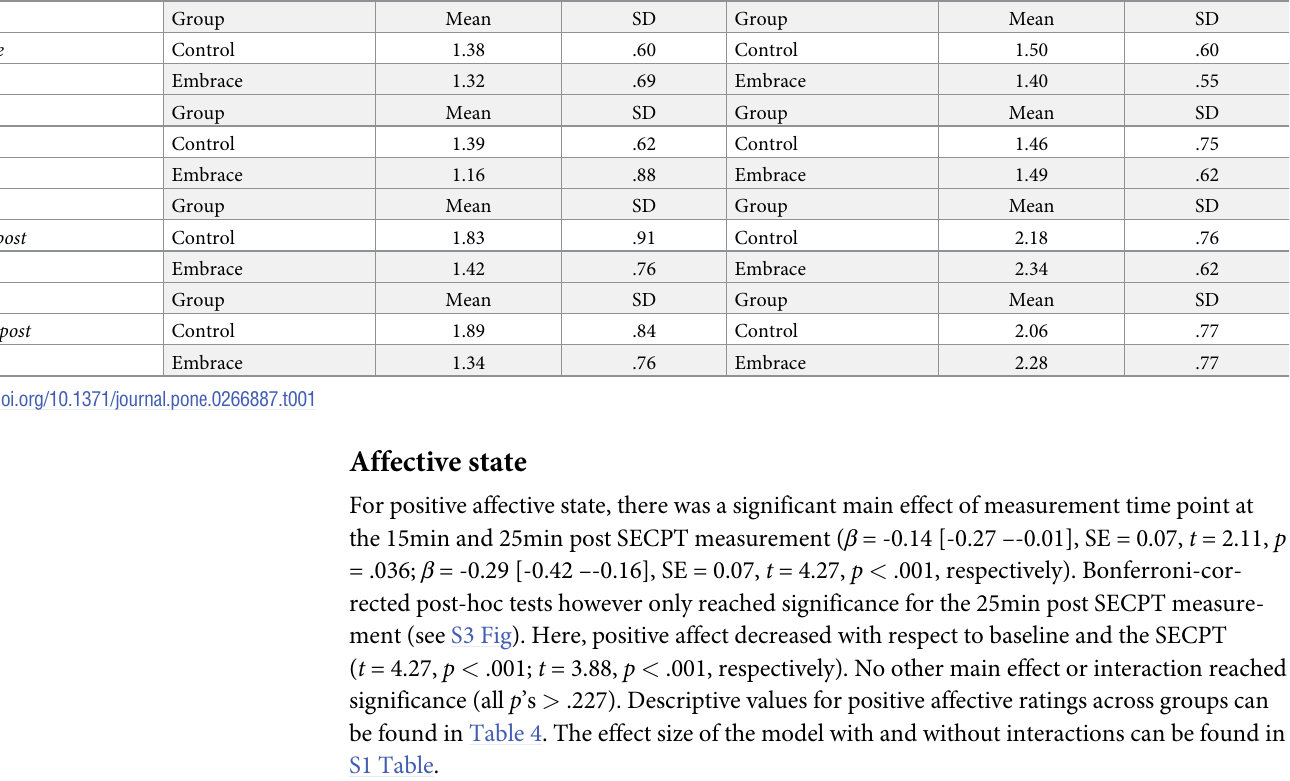
Table 1. Descriptive values (mean value and standard deviation) of logarithmized cortisol values across the four measurement time points broken down by condi- tion and sex. Time point